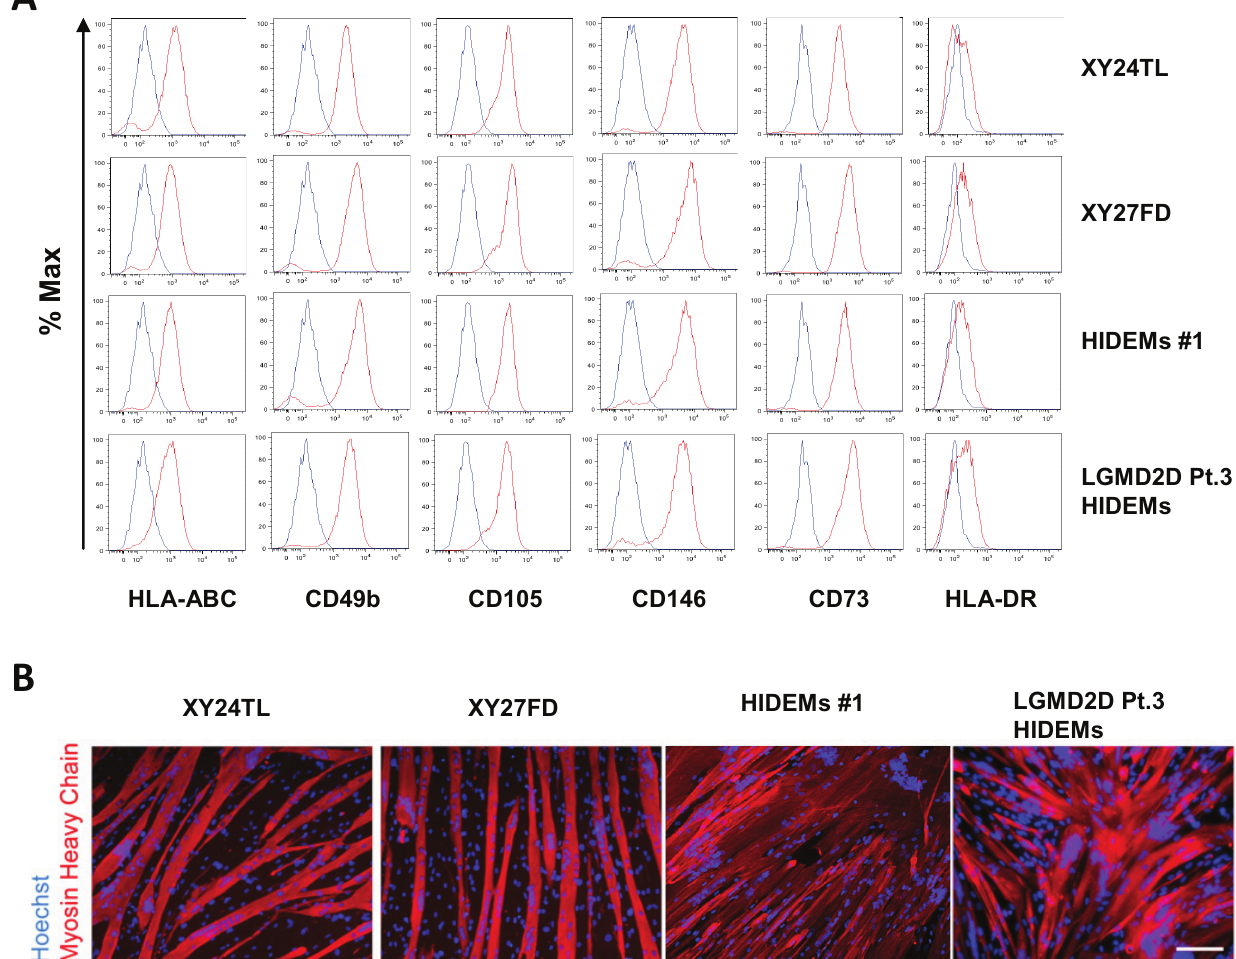
Figure 1. HIDEM and mesoangioblast surface marker phenotype and differentiation capabilities. Healthy donor HIDEM line #1 and LGMD2D HIDEMs from patient no. 3 (HIDEMs Pt.3) and mesoangioblasts XY24TL and XY27FD were analysed for their surface marker expression of HLA-ABC, HLA-DR, CD105, CD73, CD49b and CD146 ( A ). Mesoangioblasts were stained with fluorochrome-labelled antibodies against the above markers (shown in red) as well as isotype matched control antibodies (shown in blue) followed by flow cytometric analysis. All four cell lines were also induced for myogenic differentiation followed by immunostaining of myocyte/myotube marker Myosin Heavy Chain (red). Cell nuclei were counter stained with Hoechst (blue). Scale bar = 100 µm ( B